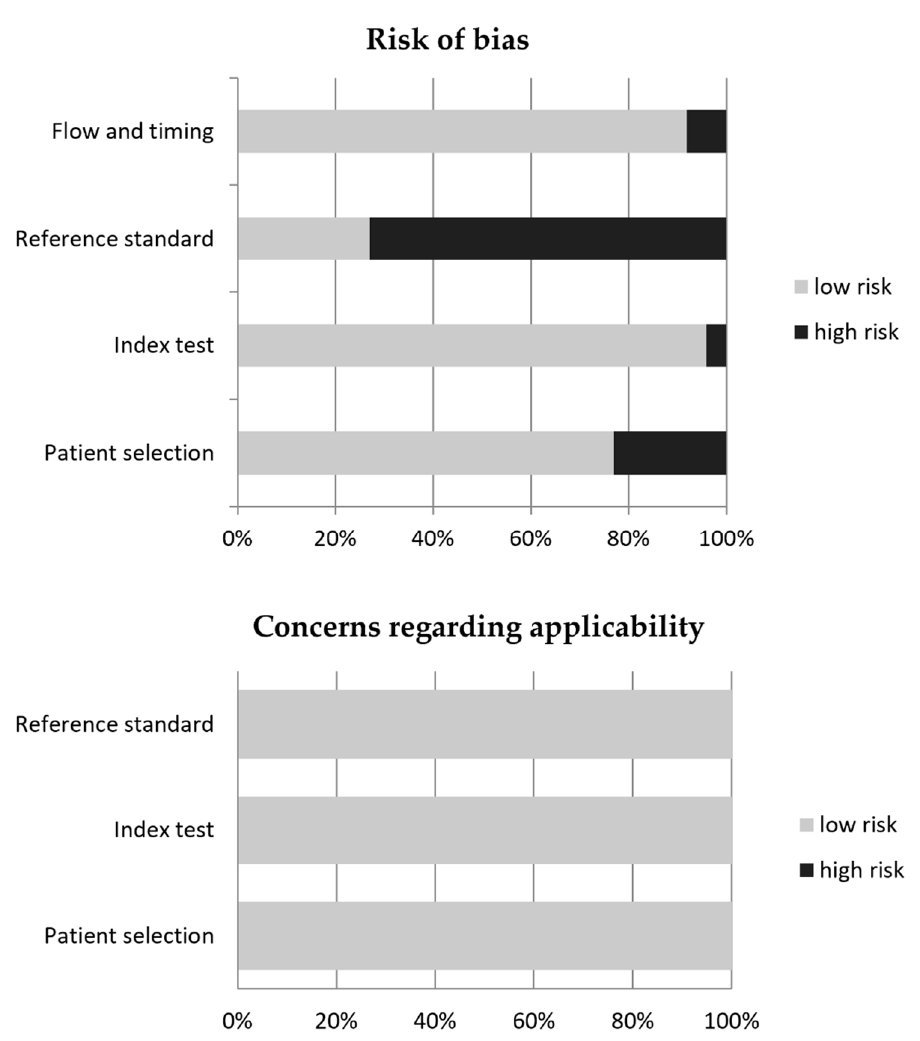
Figure 2. Quality assessment of the included studies according to QUADAS-2 tool.